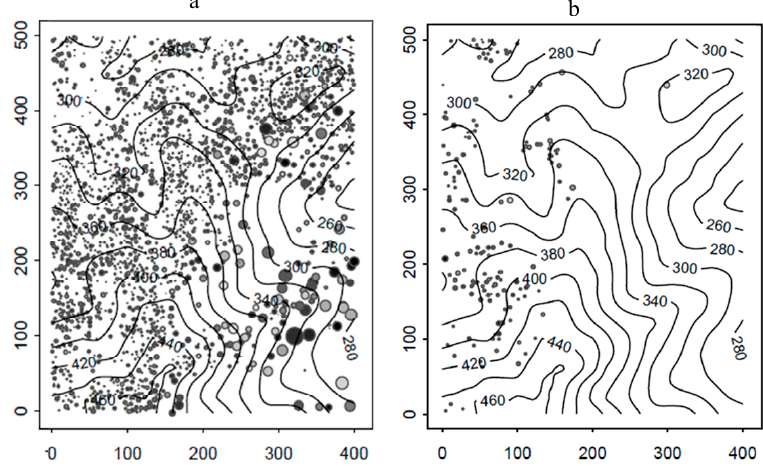
Figure 1. Distribution of Castanopsis chinensis ( a ) and Pinus massoniana ( b ) trees ≥ 1 cm DBH in the 20 ha DHS plot. Dot size was characterized in equal proportion of individual’s DBH.